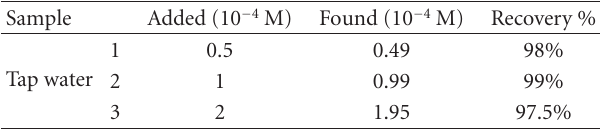
Figure 7: E ff ects of UA, AA, and AP interferences on the ampe- rometric response to H 2 O 2 in 5 mL 0.01 M NaOH + 0.09 M KCl solution. Table 2: The detection results of H 2 O 2 concentration in test sam-